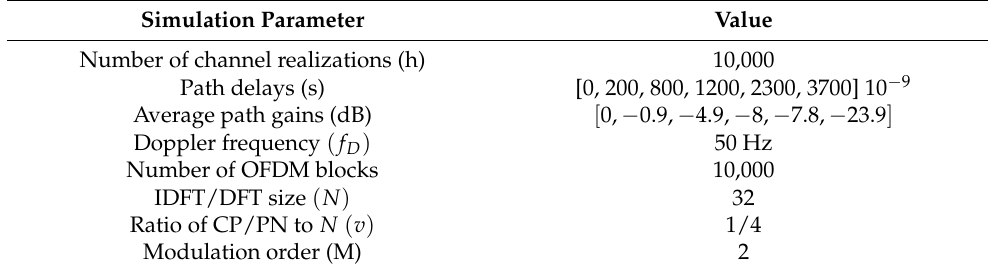
Table 3. Simulation parameters for OFDM block and ITU pedestrian B channel model.